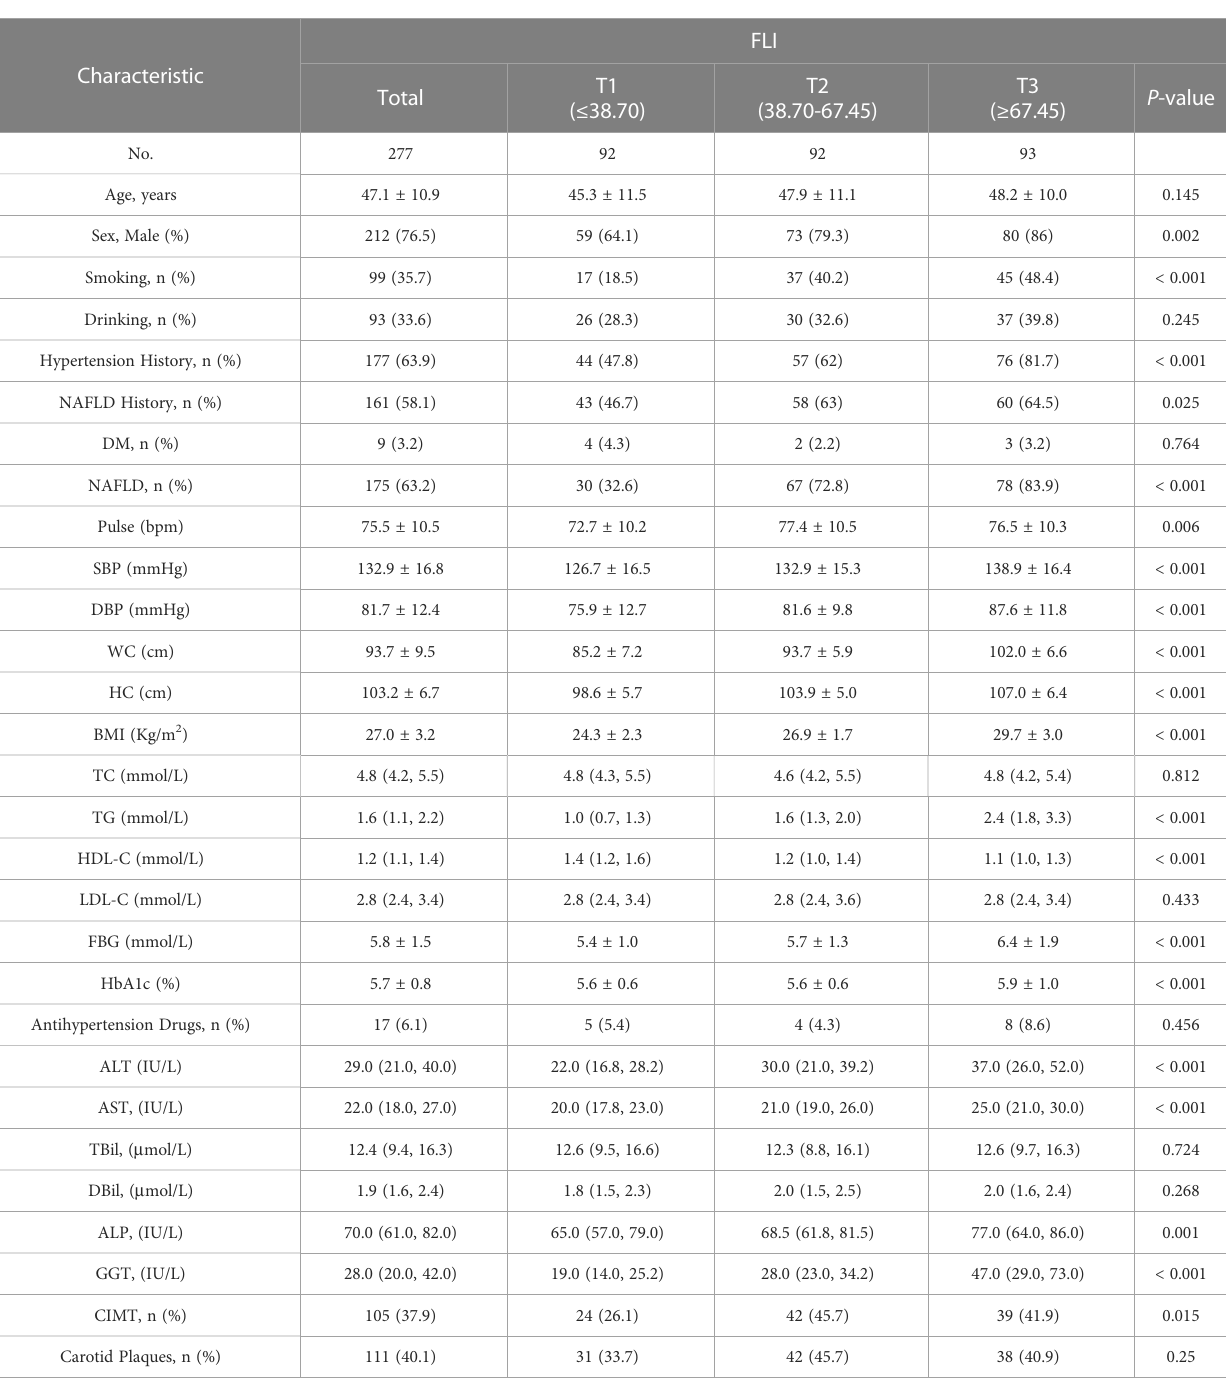
BMI, body mass index; TC, Total Cholesterol; TG, triglyceride; HDL-C, high-density lipoprotein cholesterol; LDL-C, low-density lipoprotein cholesterol; FBG, fasting blood glucose; HbA1c, glycosylated hemoglobin; ALT, alanine aminotransferase; AST, aspartate aminotransferase; TBil, total bilirubin; DBil, direct bilirubin; GGT, g -glutamyl transpeptidase; ALP, alkaline phosphatase; CIMT, carotid intima media